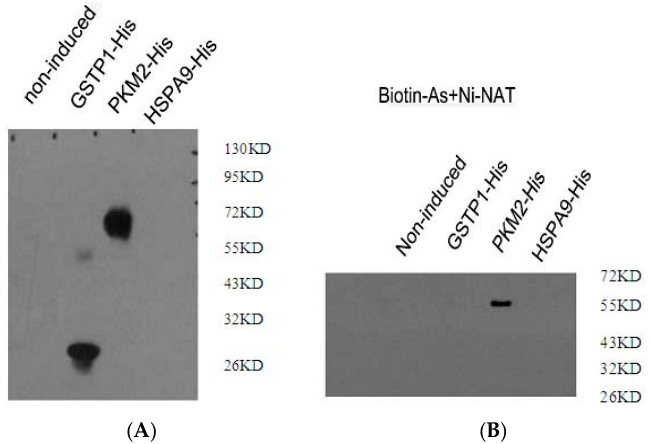
Figure 3. Detection of the interaction between arsenic-biotin and the protein in vitro . ( A ) Binding assay with His antibody; ( B ) binding assay with biotin antibody.